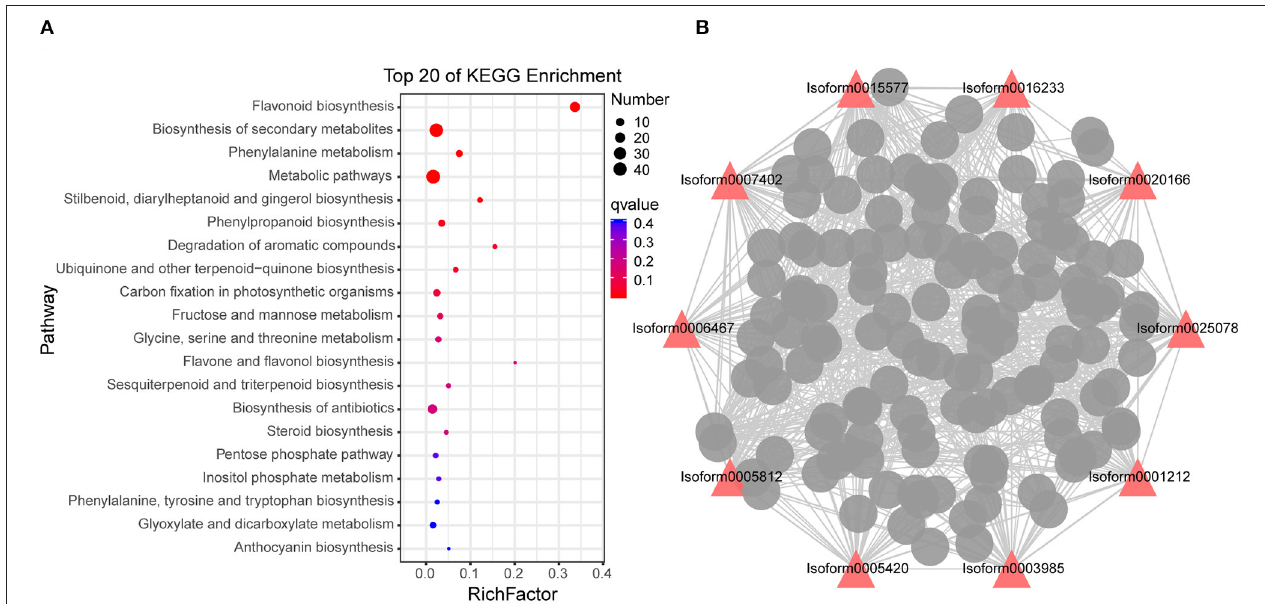
FIGURE 6 | Co-expression network analysis of grey 60 module. (A) Enriched Kyoto Encyclopedia of Genes and Genomes (KEGG pathways) of the grey 60 module genes. (B) Correlation network of genes in the grey 60 module (stage 4). q -value is a P -value that has been adjusted for the false discovery rate (FDR). A lower q -value indicates that a lower percentage of significant results will be false positives. Rich factor represents the degree of enrichment of genes under the designated pathway term, the greater the value of the rich factor, the greater the degree of pathway enrichment. Red triangles indicate the top 10 hub genes, the wider the edge, the greater the weight between the two